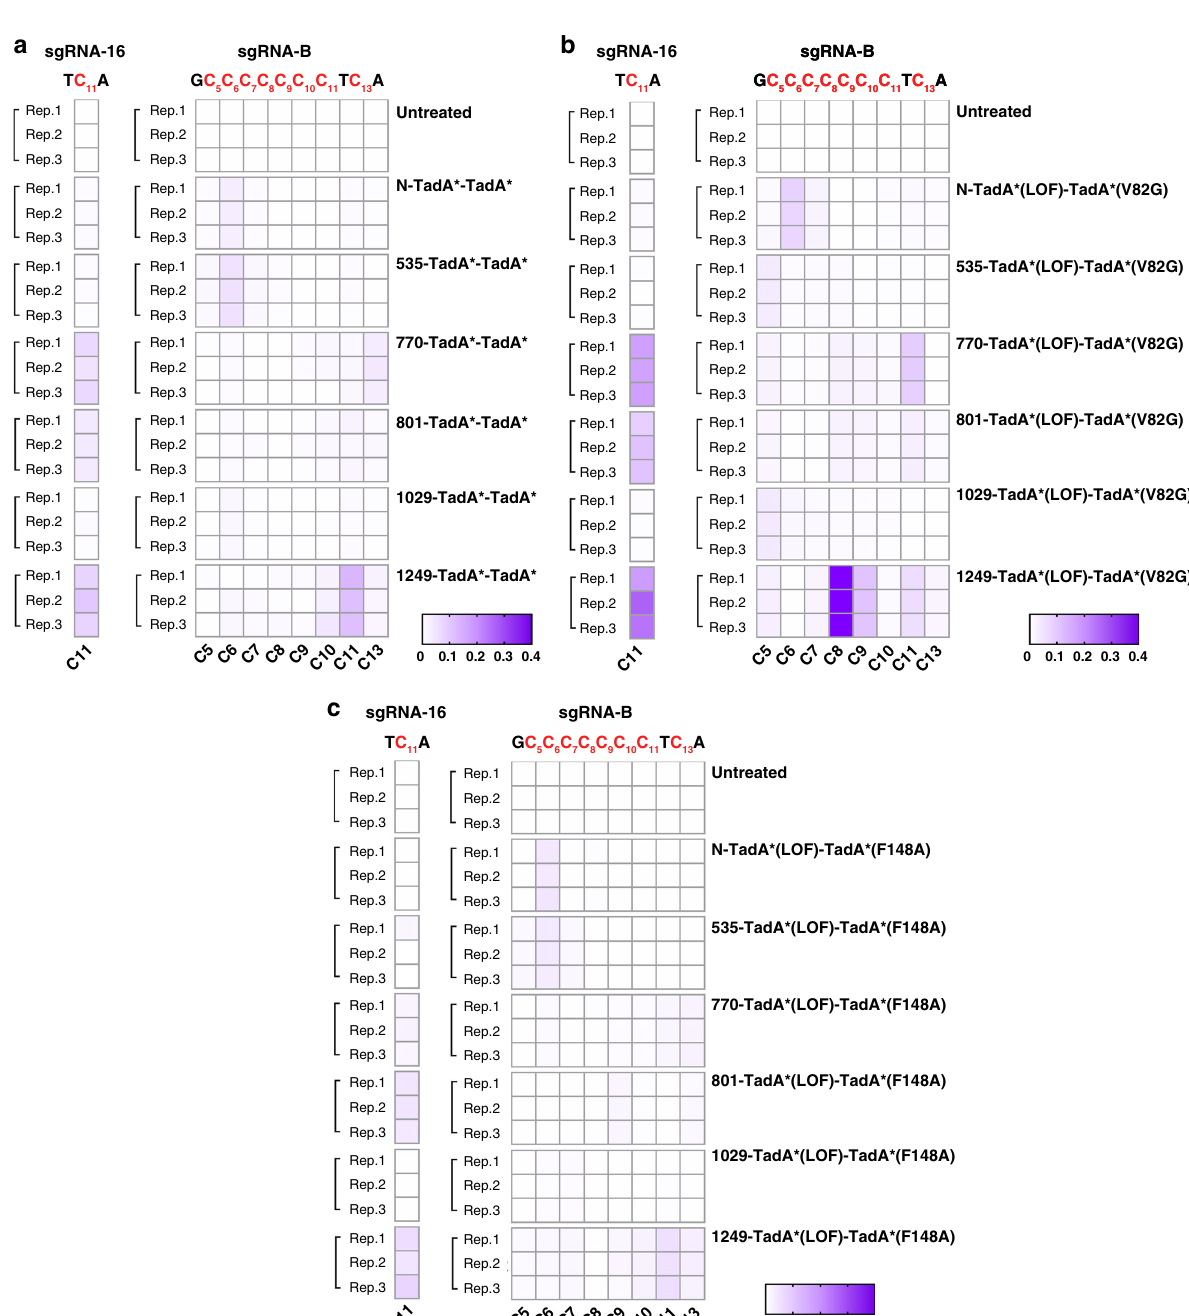
editing window expansions. Systematic analysis would be needed